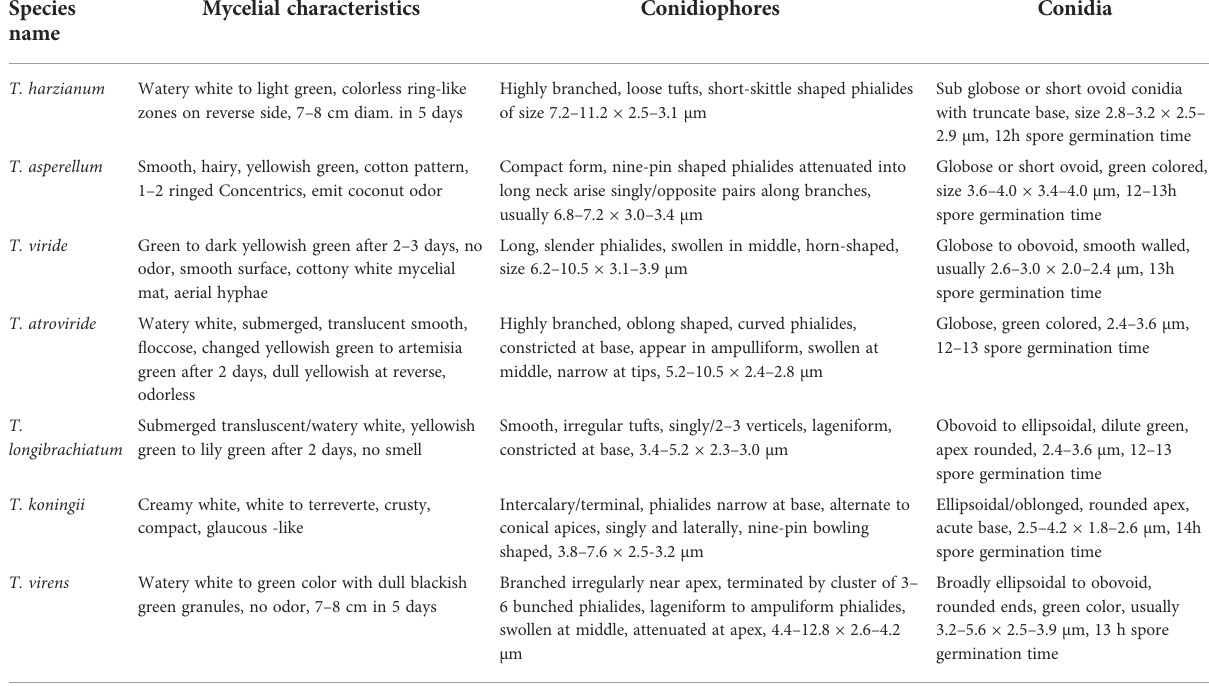
TABLE 1 Identi fi cation features of Trichoderma species based on morphological